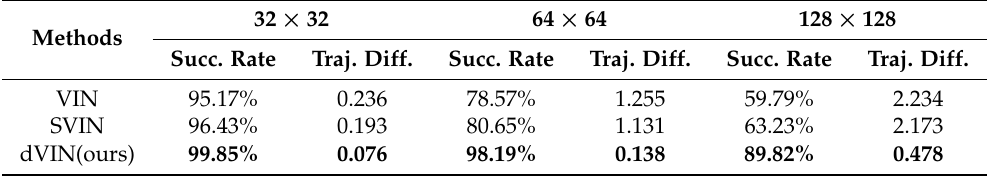
Table 4. Performance on lunar domain. For all domain sizes, the dVIN significantly outperform other VI-based models. Note that the performance gap increases dramatically with problem